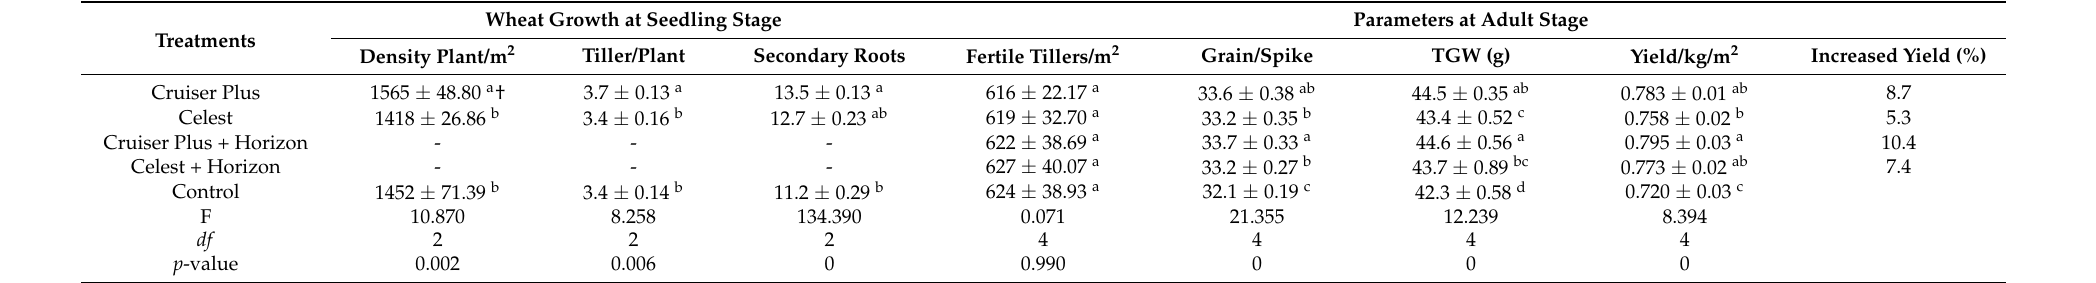
Table 4. Influence of seed dressing on wheat growth and yield parameters (Linzhang 2017).